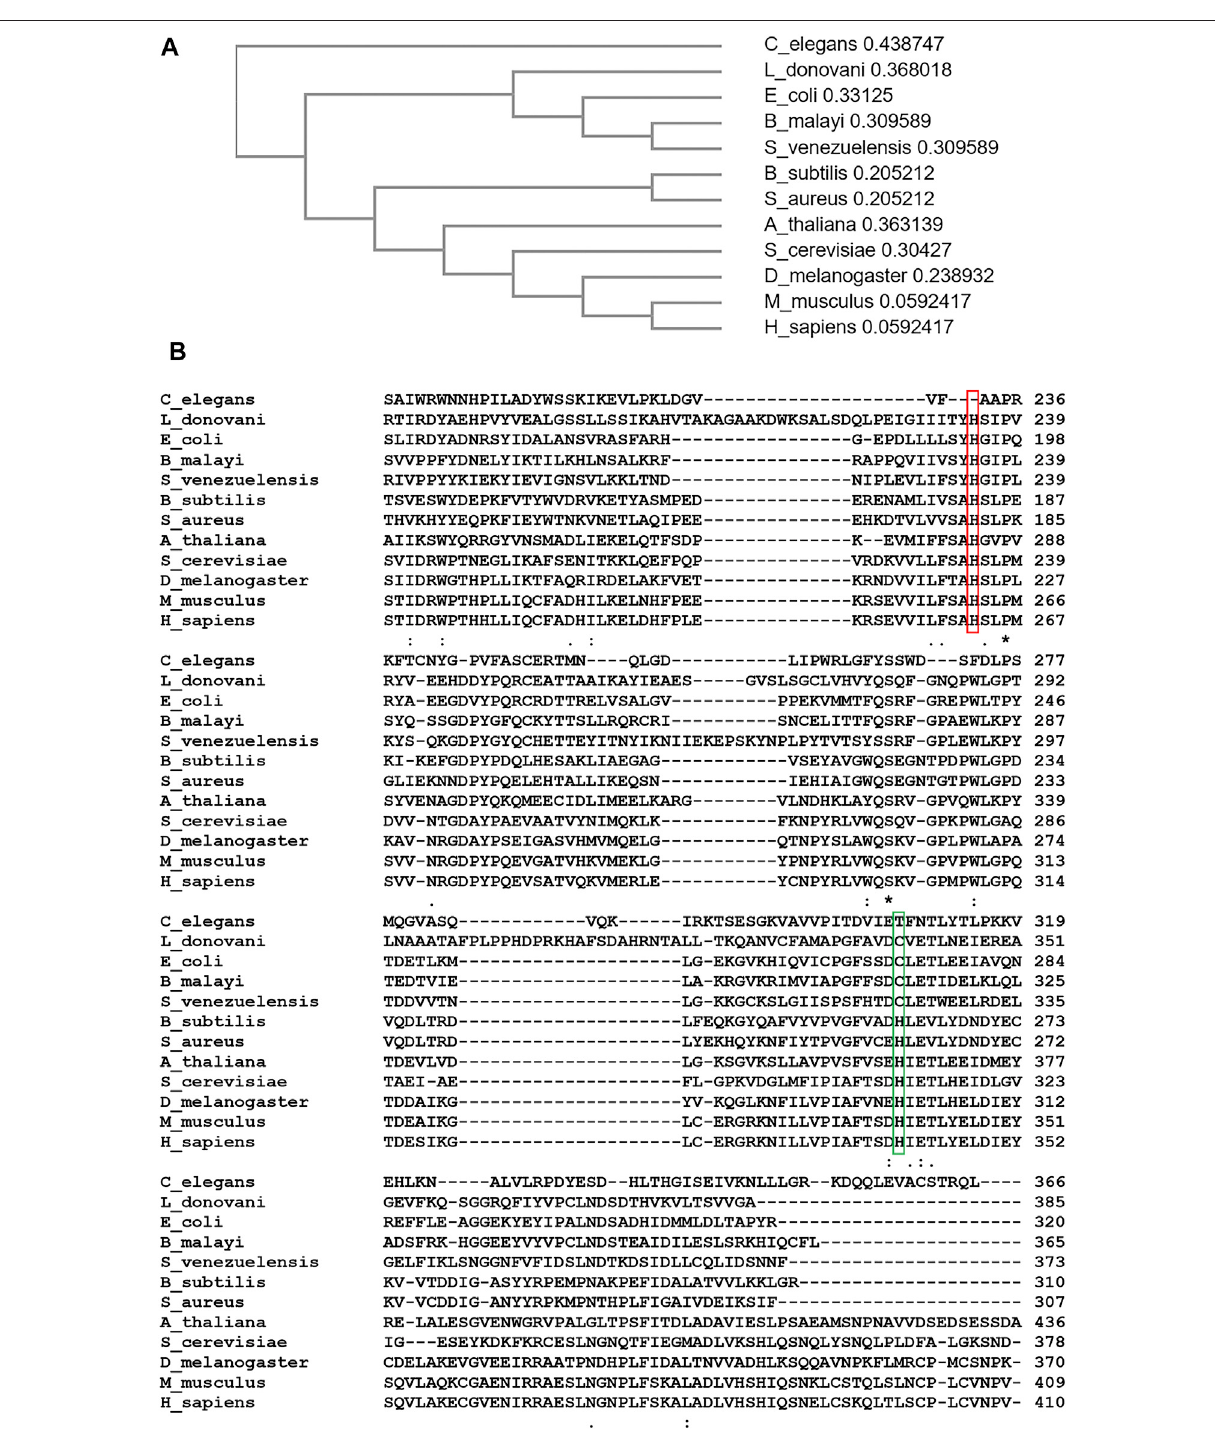
FIGURE7| SequenceAlignmentandPhylogenicAnalysesofFerrochelatase. (A) Cladogramofferrochelatasefrom Caenorhabditiselegans , Leishmaniadonovani , Escherichia coli , Brugia malayi , Strongyloides venezuelensis , Bacillus subtilis , Staphylococcus aureus , Arabidopsis thaliana , Saccharomyces cerevisiae , Drosophila melanogaster , Mus musculus , and Homo sapiens . Value after each organism represents branch length. (B) Aligned amino acid sequence of ferrochelatase from above listed organisms. Conserved “ catalytic histidine ” is highlighted in red. Cysteine residue conserved in ferrochelatases acquired from a gamma-proteobacterium is highlighted in green. (A,B) were created using Clustal Omega (Madeira et al., 2019).